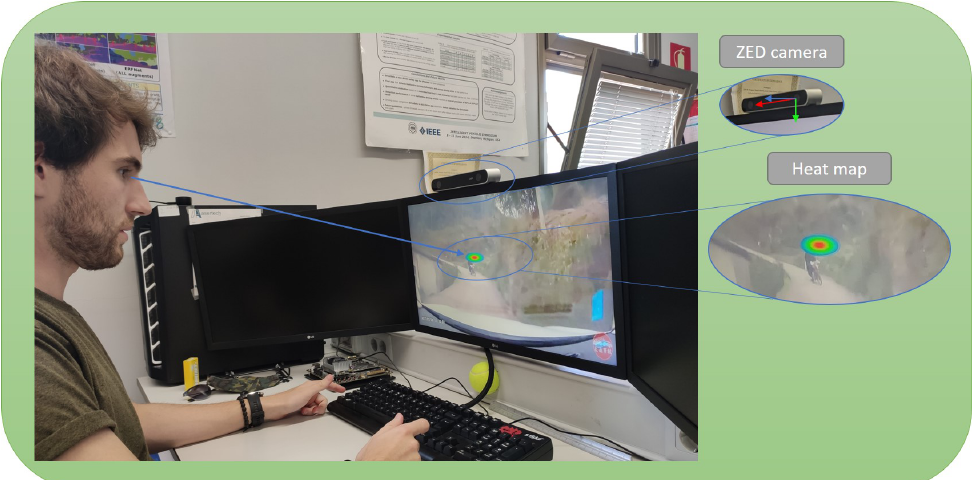
Figure 2. Full framework set-up. User looking at a 24 (cid:48)(cid:48) screen with the camera positioned in front of him, while DADA2000 videos are displayed on the screen. Heat map is generated in real